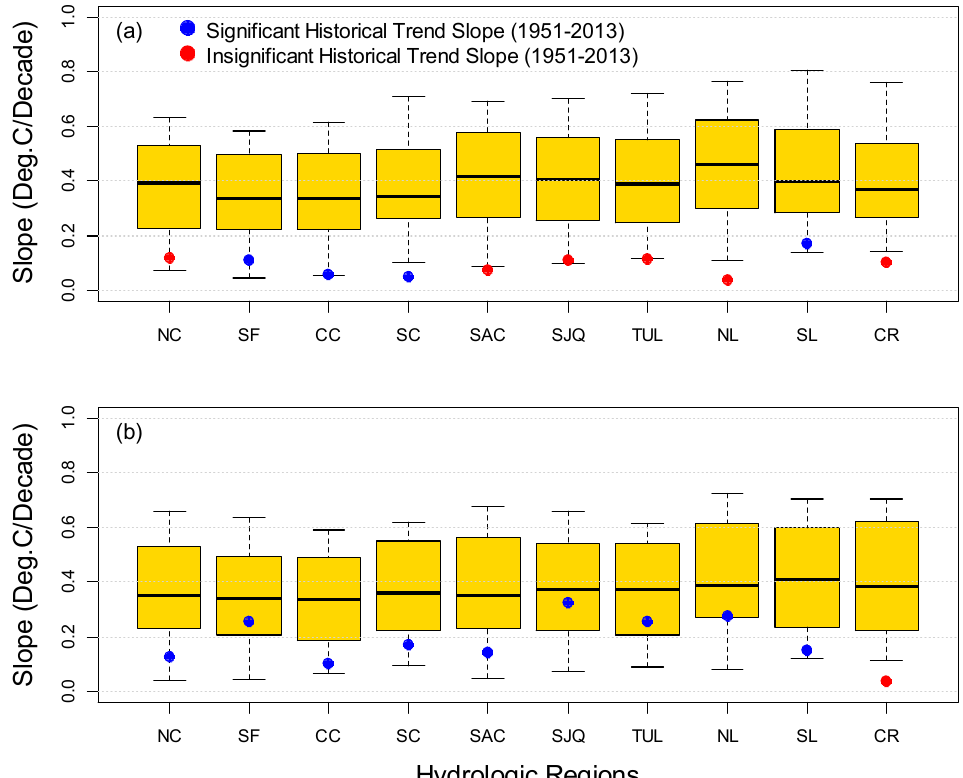
Figure 9. Box-and-whisker plots of trend slopes of historical (1951–2013) and projected (2020–2099) mean annual: ( a ) maximum temperature (Tmax); and ( b ) minimum temperature (Tmin) (at significance level 0.05).